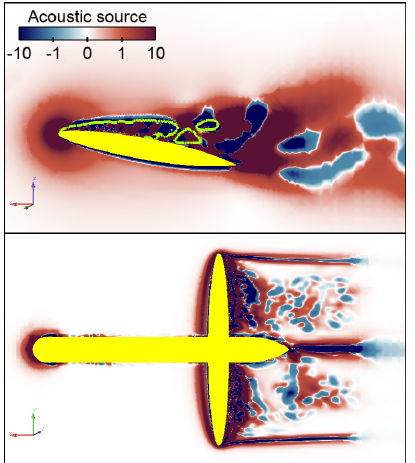
Figure 2. Illustration of acoustic source term based on the volumetric mixture velocity. A snapshot from EE flow solution. Top frames are at the y -plane taken at midchord of the left wing, and bottom frames are at the z -plane taken in the middle of the cavitator. The green lines denote a contour of α g = 0.1. The flow is from left to